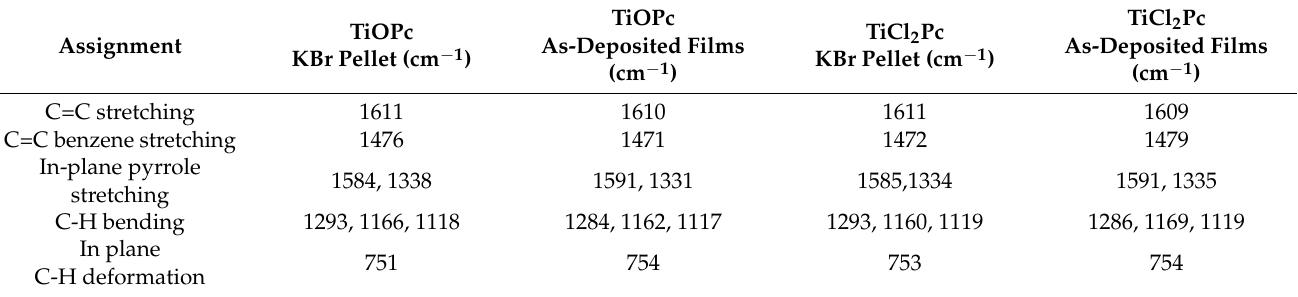
Figure 3. IR spectra of ( a ) TiOPc, ( b ) TiCl 2 Pc in pellet and thin film and ( c ) TiOPc in a range of 700 to 800 cm − 1 . Table 1. Comparison between the IR signals obtained for TiOPc and TiCl 2 Pc in KBr pellet and film over silicon.